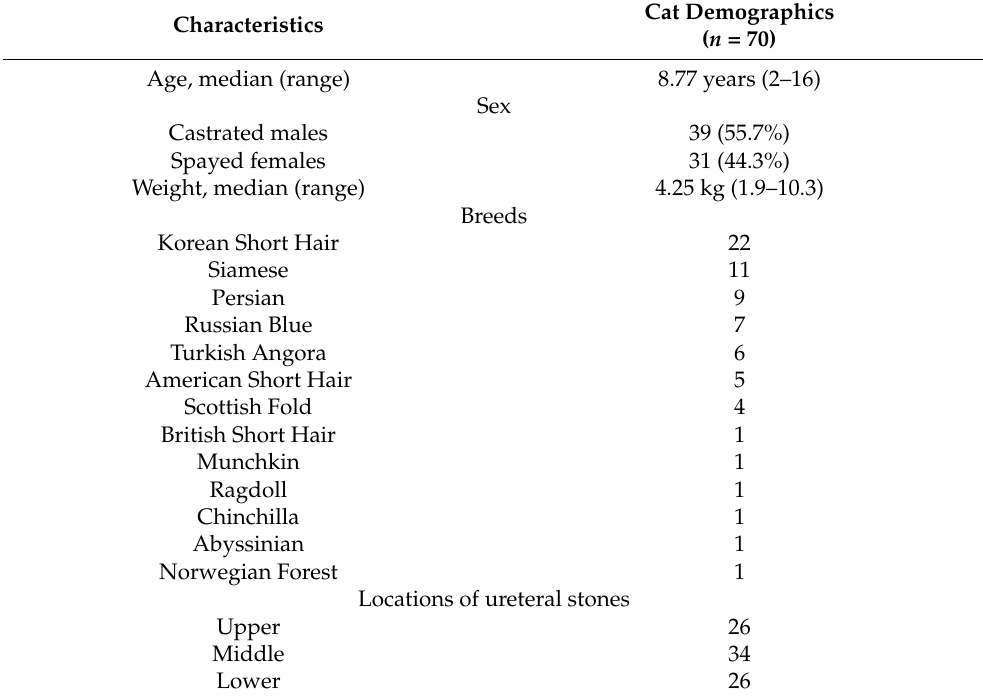
Table 1. Cat demographics.